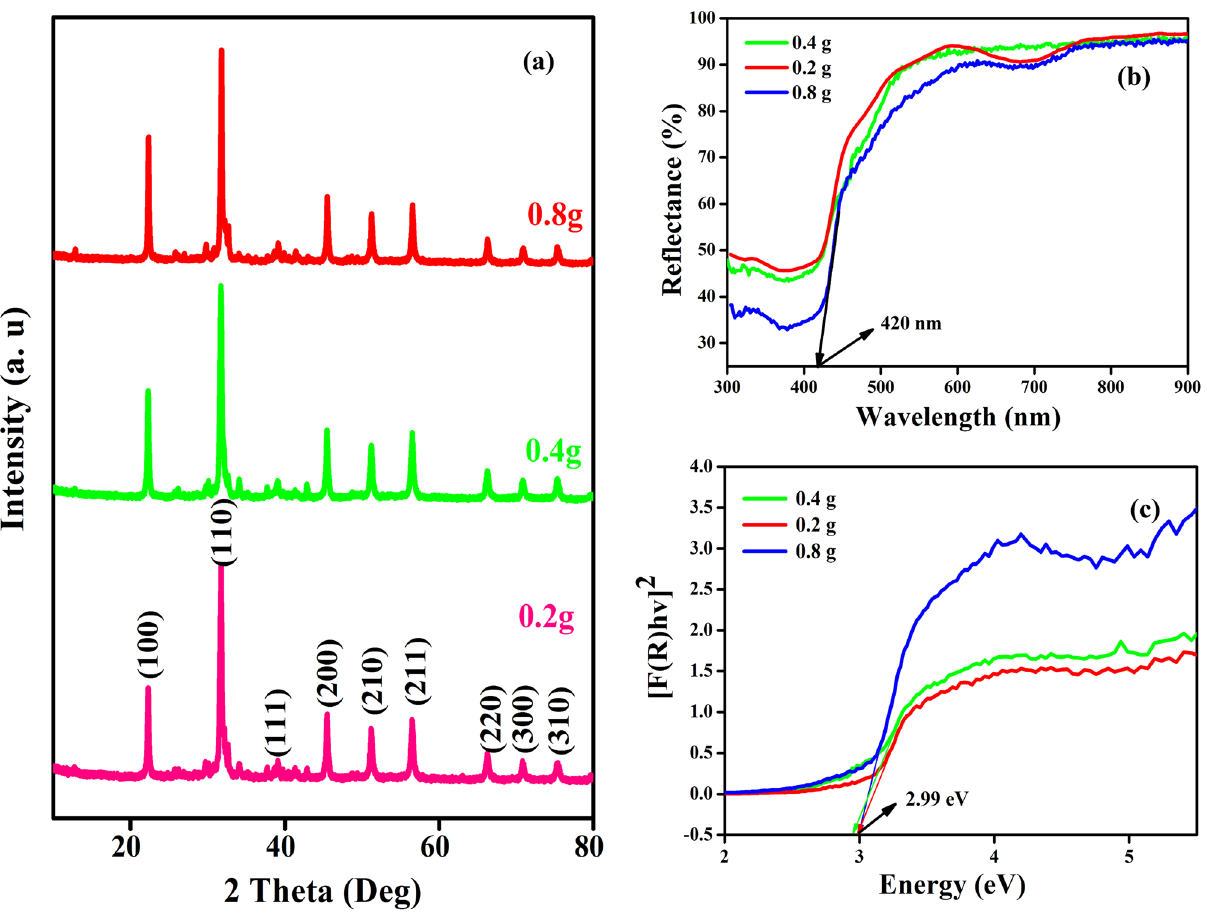
Figure 1. ( a ) Intense XRD peaks of 3D-F-KT NPs prepared by 0.2, 0.4, 0.8 g concentration of areca seed powder. ( b ) Diffuse reflectance spectra showing absorption towards visible region on increasing areca fuel weight of 3D-F-KT. ( c ) Controlled Direct band gap energy (E g ) of 3D-F-KT NPs achieved by increasing fuel